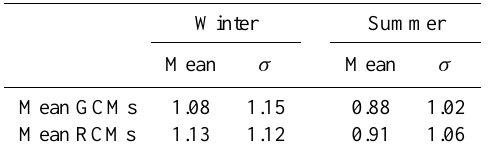
of the distribution ( P 90 , E ) in these simulations. For both the GCM and RCM simulations, the decrease in mean summer precipitation is accompanied by an increase in the standard deviation of the 5-day precipitation